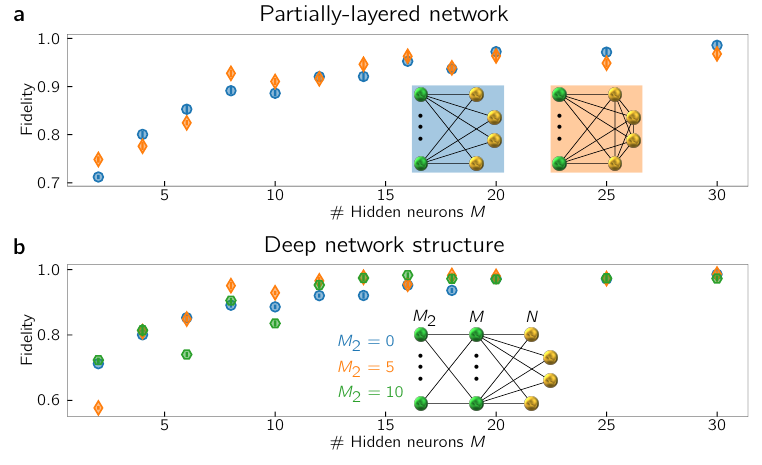
Figure 4: Extending the network architecture. a , Fidelity between network- encoded and perfect Bell state, Eq. (5), as a function of the number of hidden neurons for strictly layered network (blue) and an architecture with additional connections between the visible neurons (orange). b , Quantum fidelity for states encoded in a deep network architecture with a second hidden layer containing 5 (orange) and 10 (green) neurons compared to the restricted two-layer network